Question: Author a descriptive caption for the visualization shown.
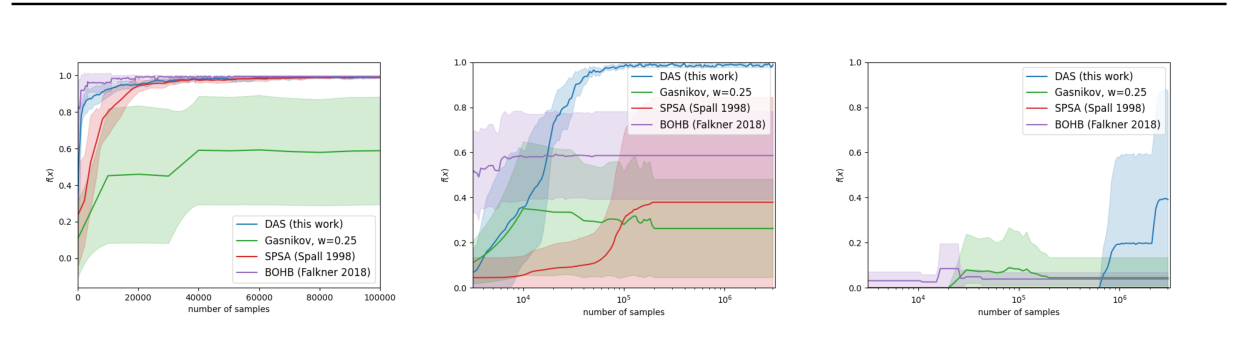
Answer: Fitness as a function of ns on the modified Rosenbrock function in different dimensions for four different algorithms. Left: D = 2, β = 0.5, Middle: D = 4, β = 0.5, Right: D = 8, β = 0.2. Traces are averages over 5 runs, and shaded regions represens one standard deviation of the data. Except for BOHB, each algorithm is initialized with an initial condition in [0, 1]D and BOHB uses [0, 1]D